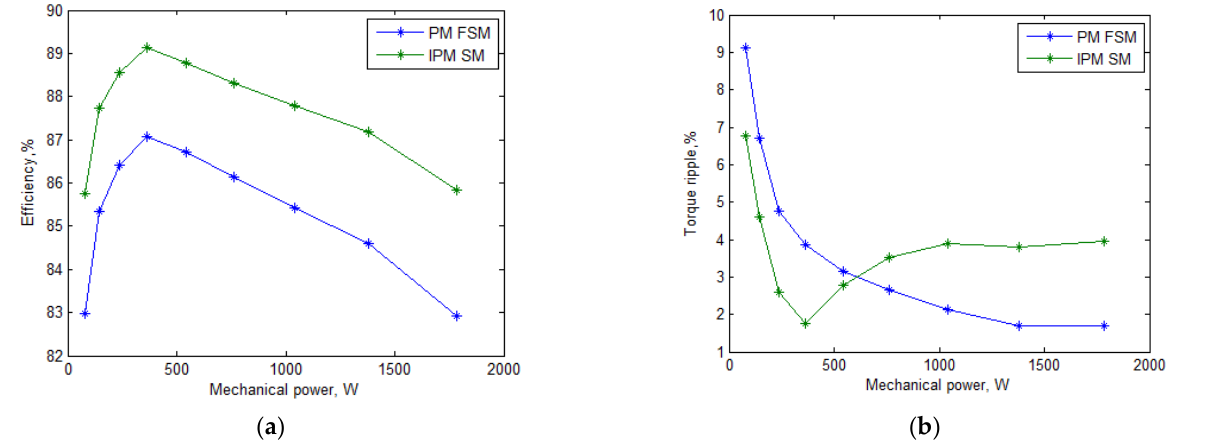
Figure 11. Comparative dependencies on mechanical power: ( a ) efficiency ( b ) torque ripple.